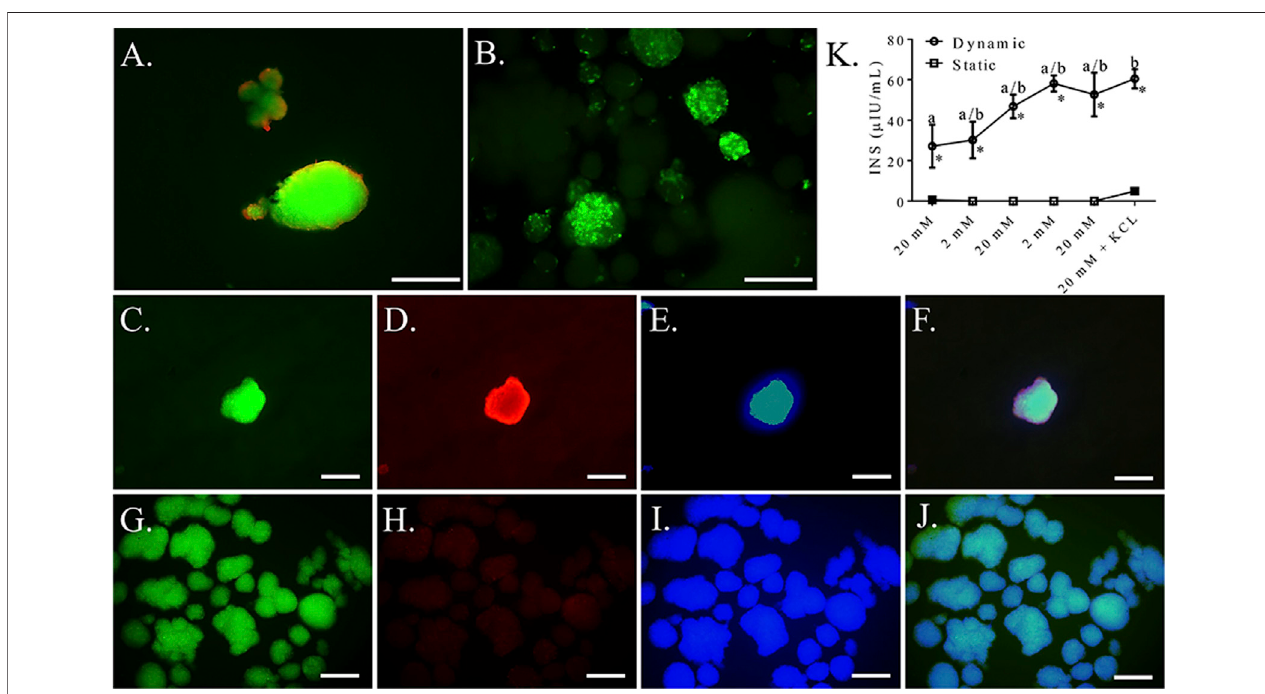
FIGURE11| FluorescentphotomicrographsoffelineASCclustersculturedfollowingcultureinpancreaticdifferentiationmediumwithout (A,C – F) andwith (B,C – J) dynamic culture and stained with viability stain [ (A,B) , viable — green, non-viable — red] or anti-insulin [ (C,G) , green], anti-glucagon [ (D,H) , blue], or DAPI [ (E,I) , blue] separately and with images merged (F,J) . Scale bars = 100 μ m. Insulin secretion (INS) by the same clusters cultured without (Static) and with (Dynamic) mechanical agitationfollowingexposuretoalternatinglow(2 mM)andhigh(20 mM)glucoseconcentrationsfor30 mineachfollowedbydepolarizationwithpotassiumchloride (KCL)inlowglucose buffer (K) .Datapoints withdistinctsuperscriptsare signi fi cantlydifferentamongincubation periods within cultureconditionand differentasterisk(*) numbers indicate differences between static and dynamic culture conditions glucose concentration ( p <